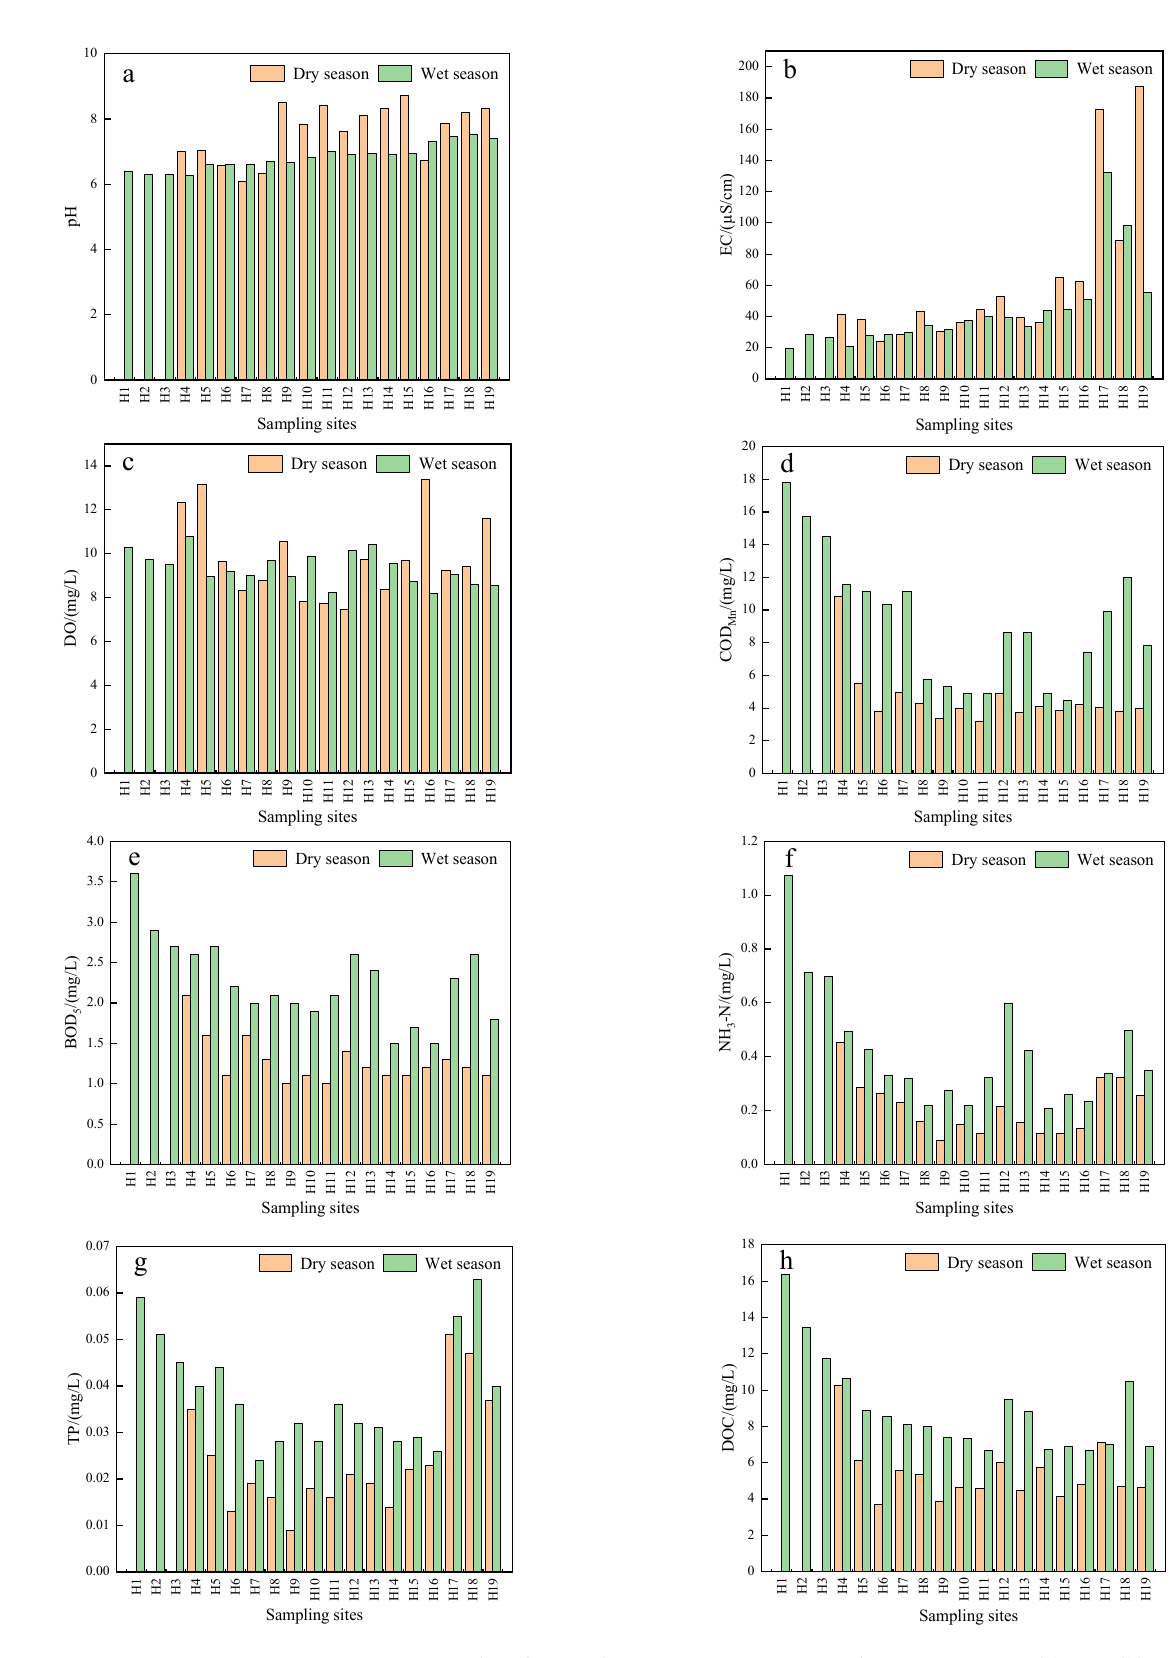
5 of 16 to explore the intrinsic relationships between environmental factors and DOM optical characteristics. 3. Results and Discussion 3.1. Seasonal and Spatial Variations in Water Quality Seasonal and spatial variations in water quality parameters in the HRB are shown in Figure 2. Based on the data, the classifications of the parameters were evaluated. Overall,